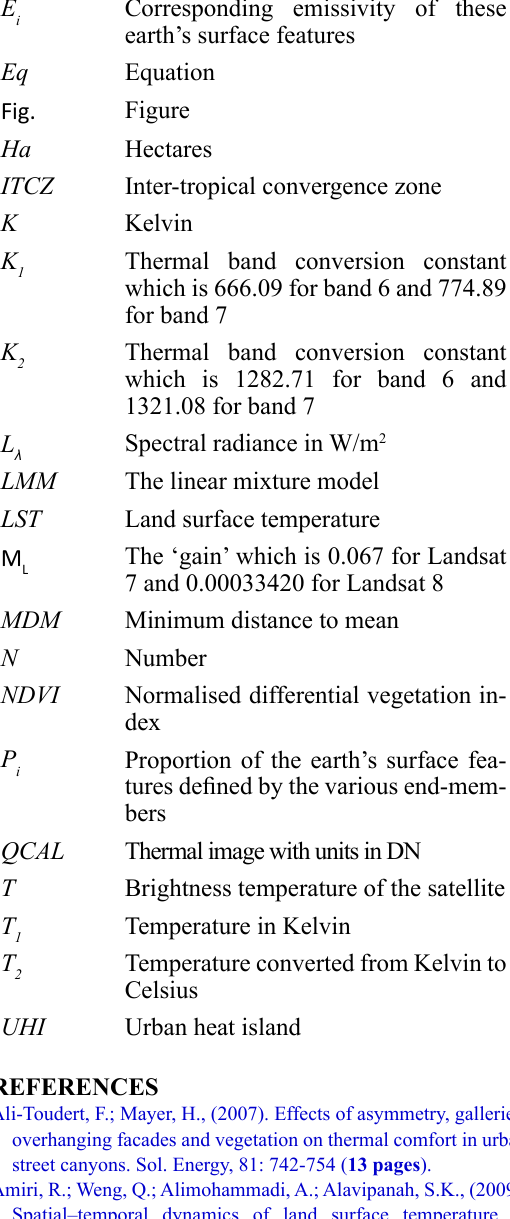
E Corresponding emissivity of these i earth’s surface features Eq Equation Ha Hectares ITCZ Inter-tropical convergence